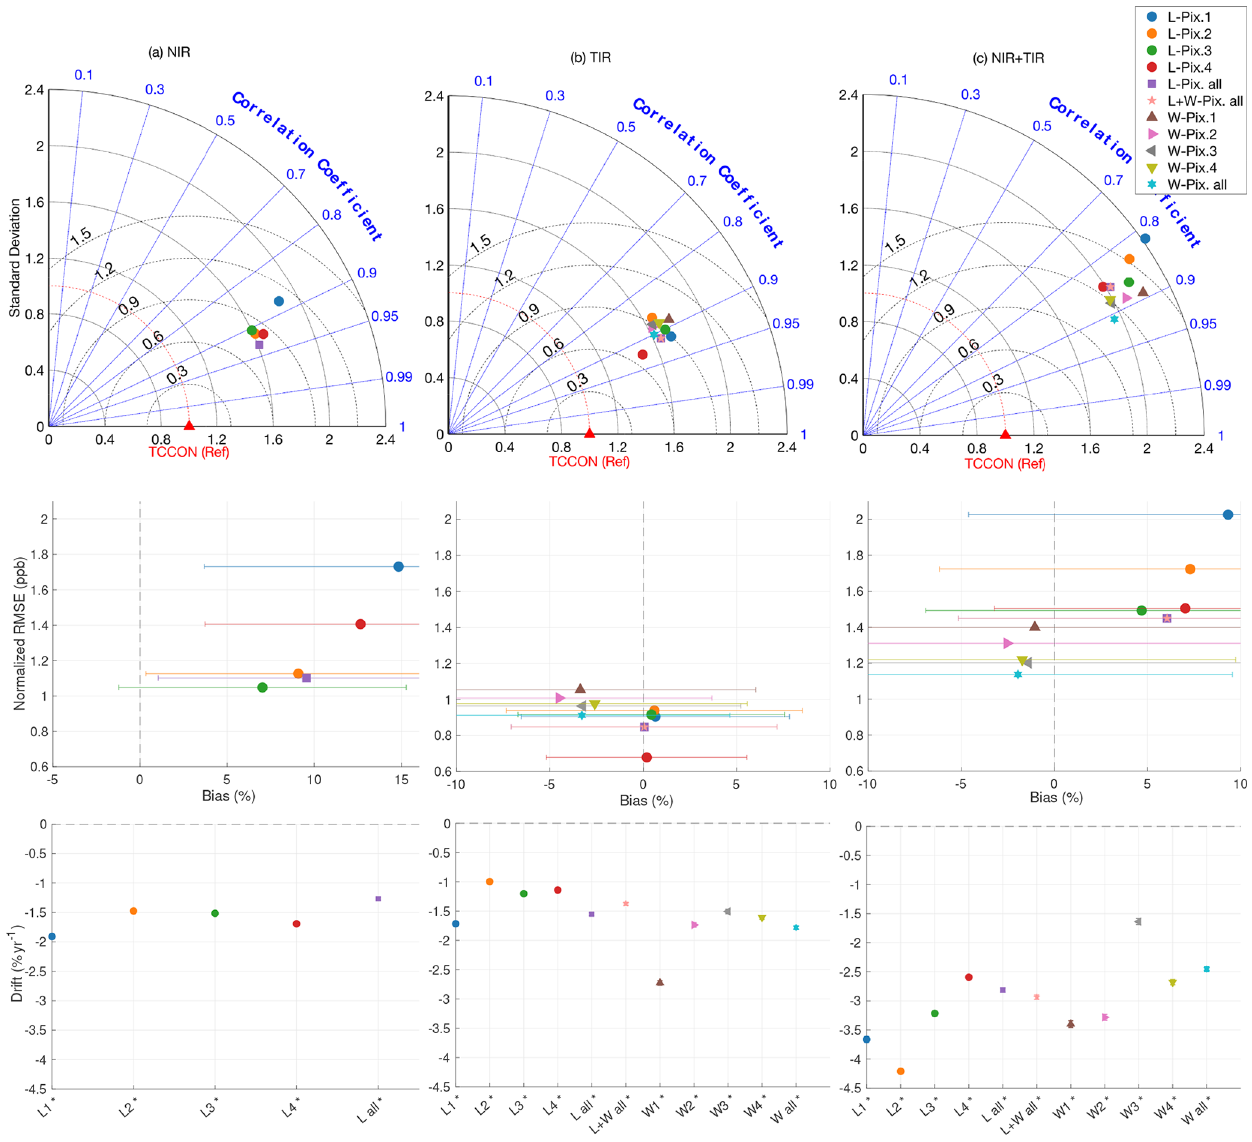
Figure 12. Same as Fig. 11 but for comparisons with TCCON